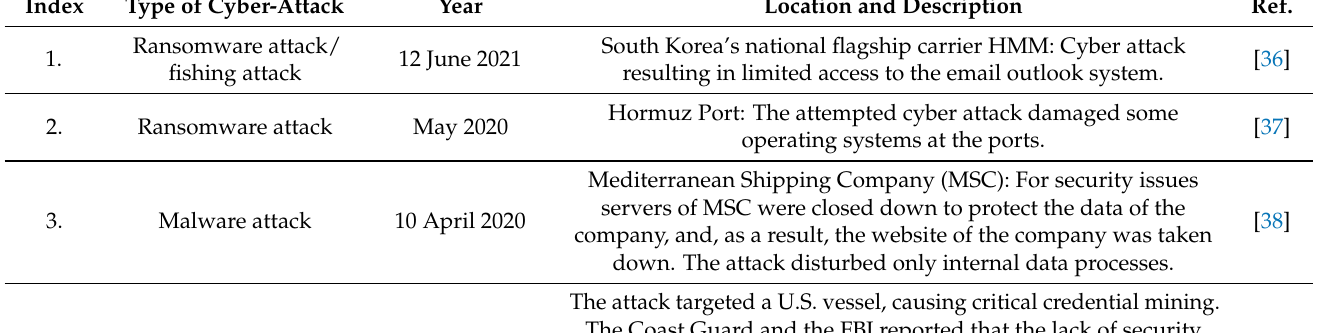
Table 2. Summary of significant previous cyber-attacks on vessels/maritime